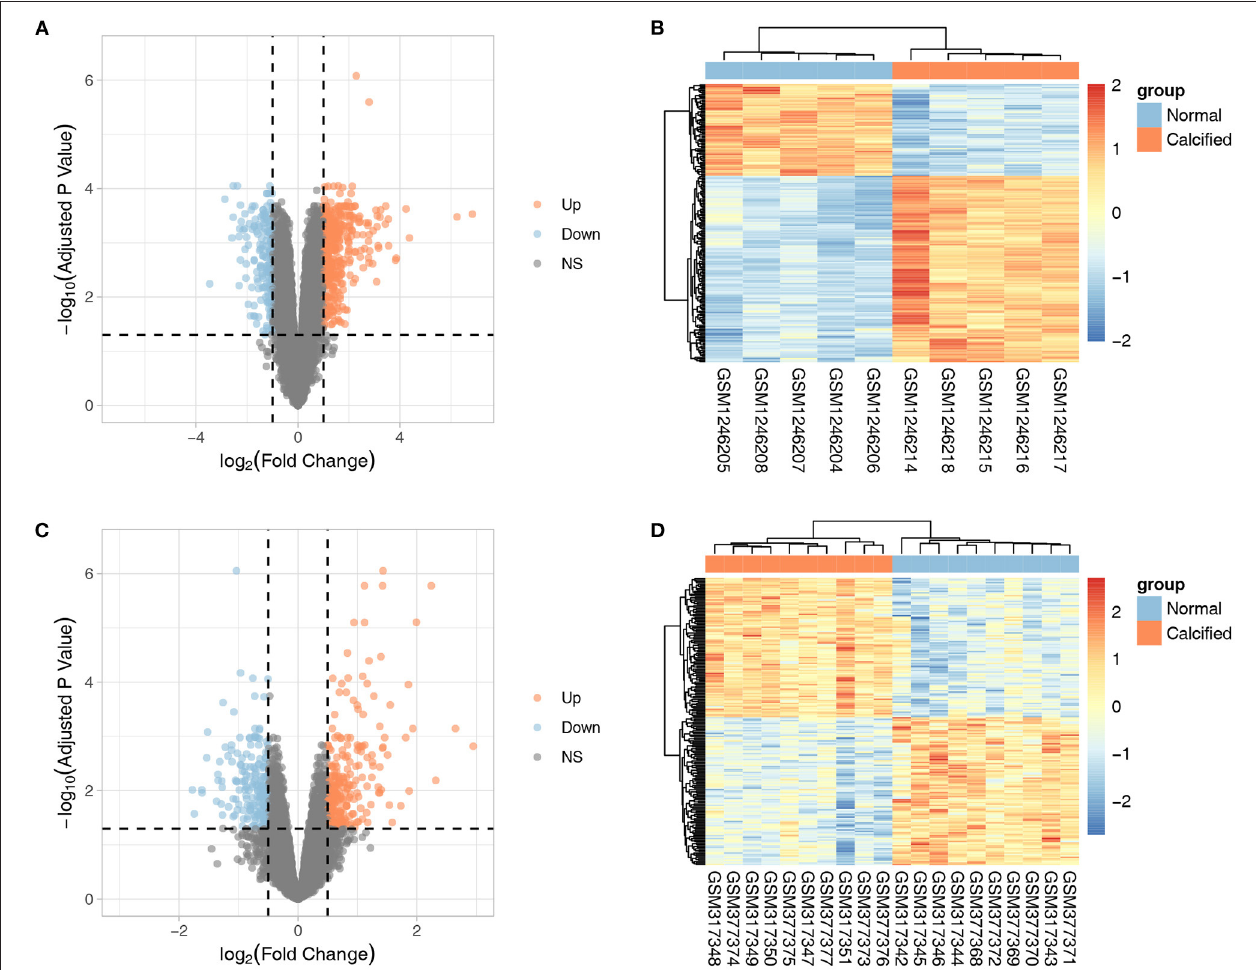
FIGURE 1 | Volcano plots and cluster heatmaps of DEGs from the two datasets. (A,B) Volcano plots and cluster heatmaps of DEGs from the GSE51472 dataset. (C,D) Volcano plots and cluster heatmaps of DEGs from the GSE12644 dataset. In the volcano plots, the orange dots represent upregulated genes, and the blue dots represent downregulated genes. In the cluster heatmaps, the red bars indicate upregulated genes, and the blue bars indicate downregulated genes. The color gradation indicates the |log 2 (fold change)|